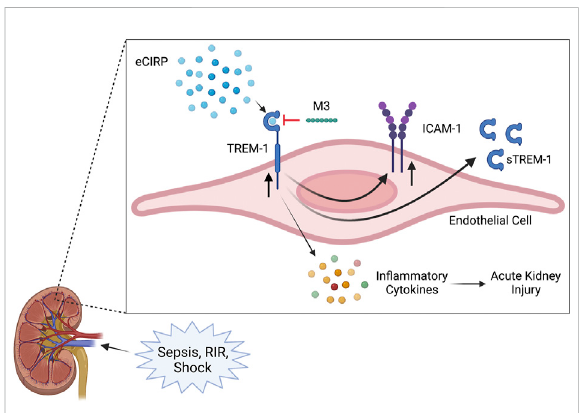
FIGURE 5 Summary of fi ndings. Sepsis and renal ischemia/reperfusion cause an increased release of eCIRP. The circulating eCIRP interacts with TREM-1 on endothelial cells, leading to increased expression of in fl ammatory cytokines, upregulating TREM-1 and ICAM-1 expression, and releasing sTREM-1. This activation leads to excessive in fl ammation and renal tissue injury and decreasing renal function, resulting in AKI. M3, a novel inhibitory peptide of the eCIRP-TREM-1 pathway, attenuates the eCIRP- dependent activation of renal endothelial cells, leading to decreased in fl ammatory cytokine release and improved AKI. Created with